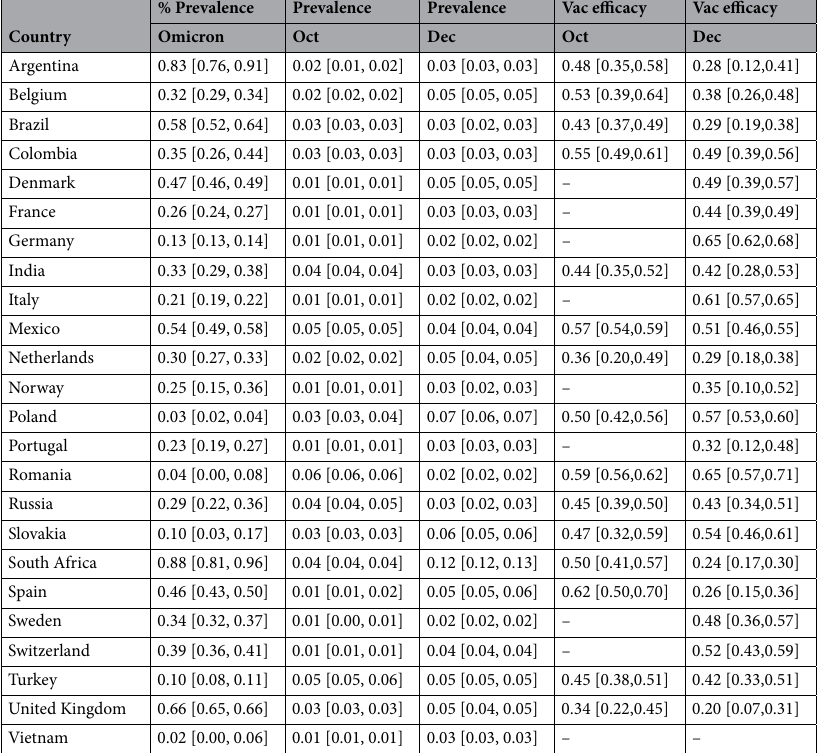
Table 2. Prevalence of Omicron in COVID-19 and vaccination efficacy in the countries with presence of Omicron (as defined in Section “Countries and time periods”). When data is insufficient to meet the defined selection criteria, it is omitted and replaced by